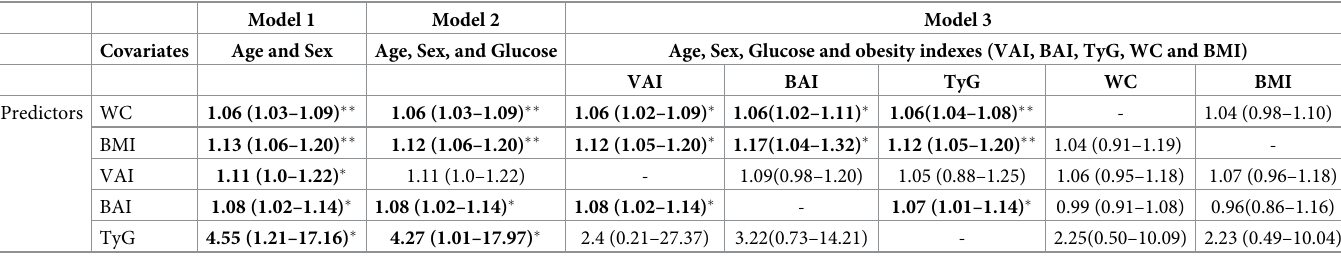
Table 3. Odds ratio in three different models of binary logistic regression (dependent variable is